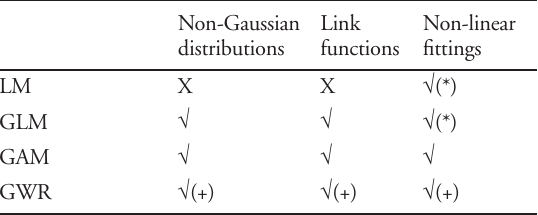
Table 1. Limitations and advantages of linear (LM) and general- ized regression approaches, GLM and GAM (* = linearization of predictor variables is required, = GWR is implemented in a GAM).